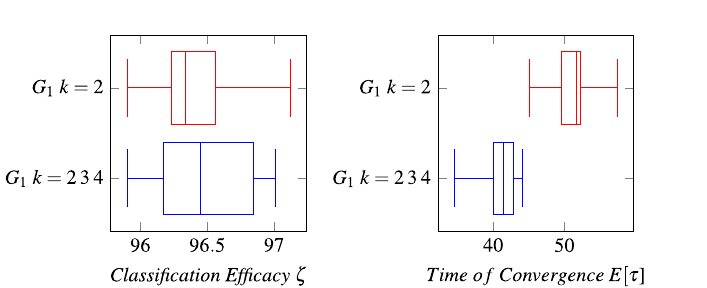
Figure 5. Comparison among MCA over Grid G 1 using k = 2, 3 or 4 neighbors and MCA using just k = 2 . Both algorithms achieve perfect consensus and their classification efficacies do not present a significant statistical difference; the reader may note the latter in the left figure. However, MCA using k = 2, 3 or 4 obtains statistically faster convergence times (right